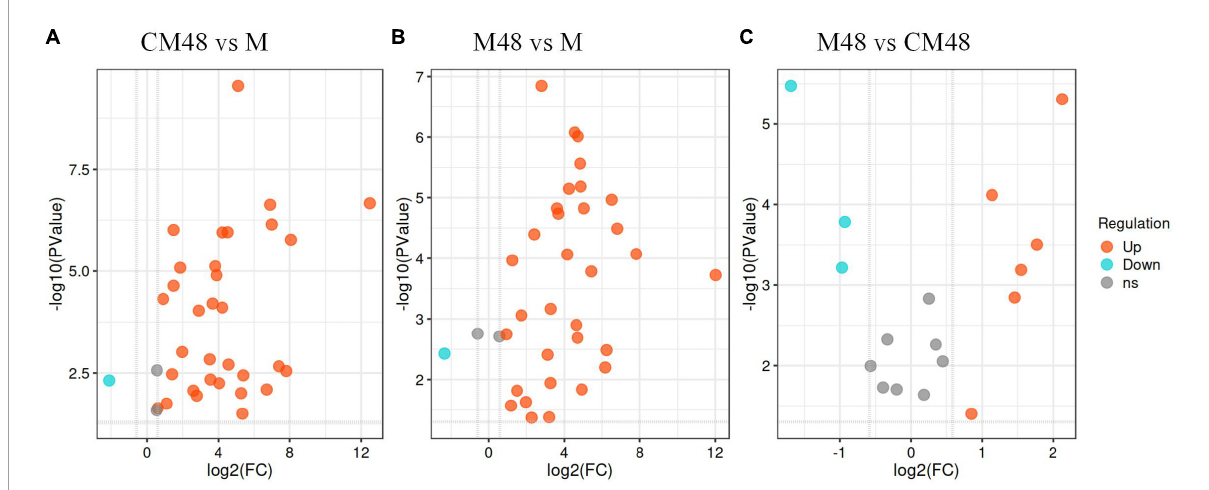
FIGURE7 Volcano plot depicting up- and down- accumulated metabolites for each pairwise comparison. M, ungerminated mung bean; CM48 vs. M (A) , M48 vs. M (B) , and M48 vs. CM48 (C) ; CM48, mung bean germinated for 48 h; M48, mung bean pretreated with a combination of ultrasonic and γ -aminobutyric acid (GABA) and germinated for 48